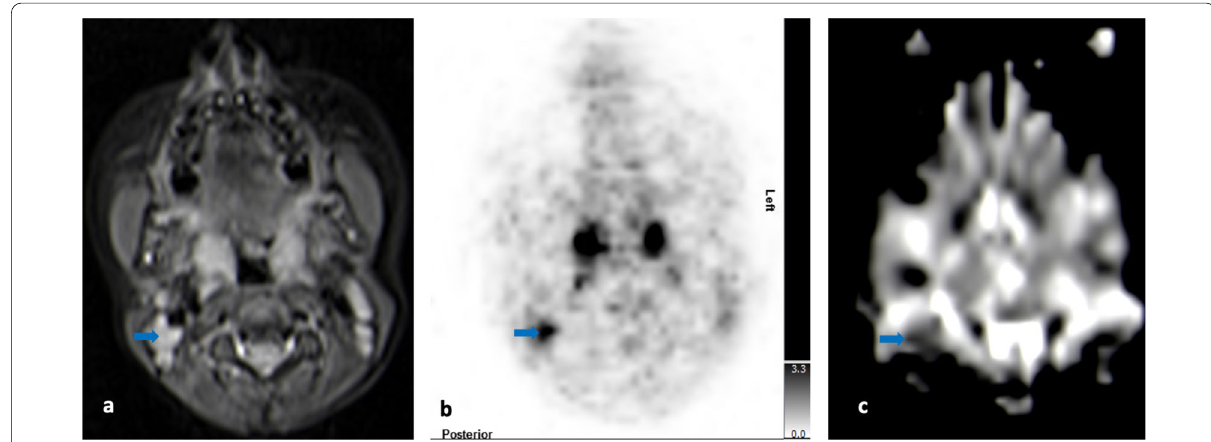
Fig. 1 a – c Upper neck (level II) on T2‑TIRM transversal ( a ), [ 18 F]‑FDG‑PET ( b ), and DWI at b‑value of 800 ( c ): The blue arrows point to morphologically inconspicuous lymph nodes on the right side ( a ) with increased glucose metabolism (SUV max right: 3.96 versus SUV max left: 1.84) ( b ) and restricted diffusion (ADC right on average: 643